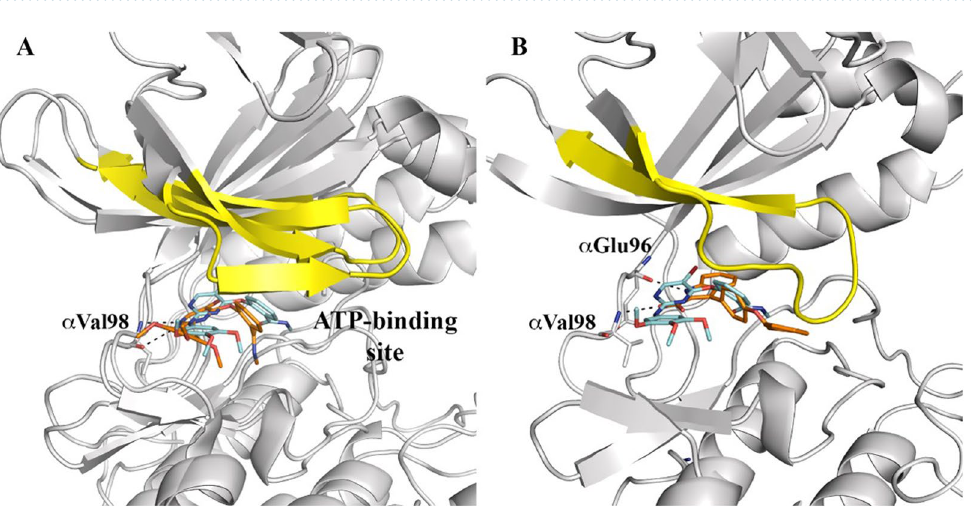
Figure 4. Representation of the binding mode of SBI-020695 and IND6 to the ATP-binding site of AMPK obtained from Molecular Dynamics simulations. ( A ) Superposition of the X-ray crystallographic structure of AMPK bound to SBI-020695 and a representative snapshot taken from the MD simulations. ( B ) Representative snapshot of the MD simulation run for the AMPK–IND6 complex. The P-loop is highlighted in yellow. SBI- 020695 and IND6 are shown in sticks. C atoms colored in cyan and orange shown the X-ray and final position of the ligand in MD simulation, respectively. Hydrogen atoms have been removed for the sake of